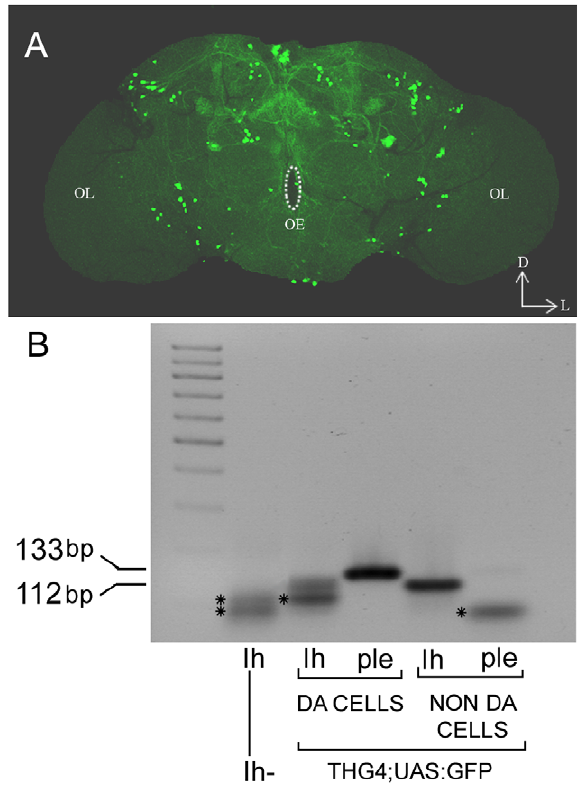
Figure 3. Ih gene is expressed in dopaminergic neurons. (A) Confocal projection of adult brain showing dopaminergic neurons labeled with GFP using the Tyrosine Hydroxilase Gal4 driver ( THG4;UAS:GFP ). D, dorsal, L, lateral, OE, oesophagus, OL, optic lobe. (B) RT-PCR amplification of Ih (112 bp) and ple (133 bp) RNAs from 200 isolated dopaminergic and non-dopaminergic neurons sorted by Fluorescence Activated Cell Sorting (FACS). Image shows amplification of Ih RNA in dopaminergic, ple -expressing neurons. Failure to PCR- amplify the neuronal ple RNA isoform in non-dopaminergic neurons (GFP negative cells) confirms that cells have been correctly sorted. Asterisks in lanes 1, 2, and 5 point to nonspecific bands, which were obtained in the negative controls ( DmIh mutant brain-RNA extract for Ih –lane 1- and GFP-negative cell-RNA extract for ple –lane 5-).